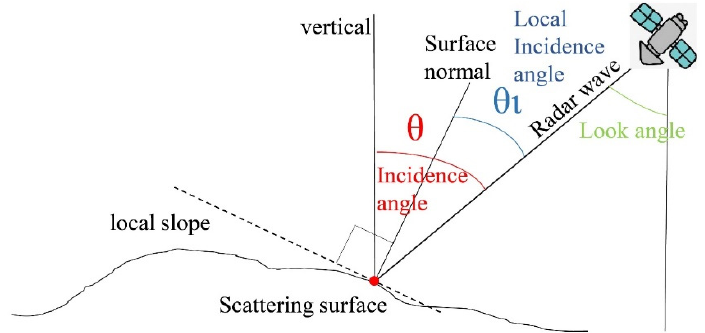
Figure 3. The geometry of the incidence angle.